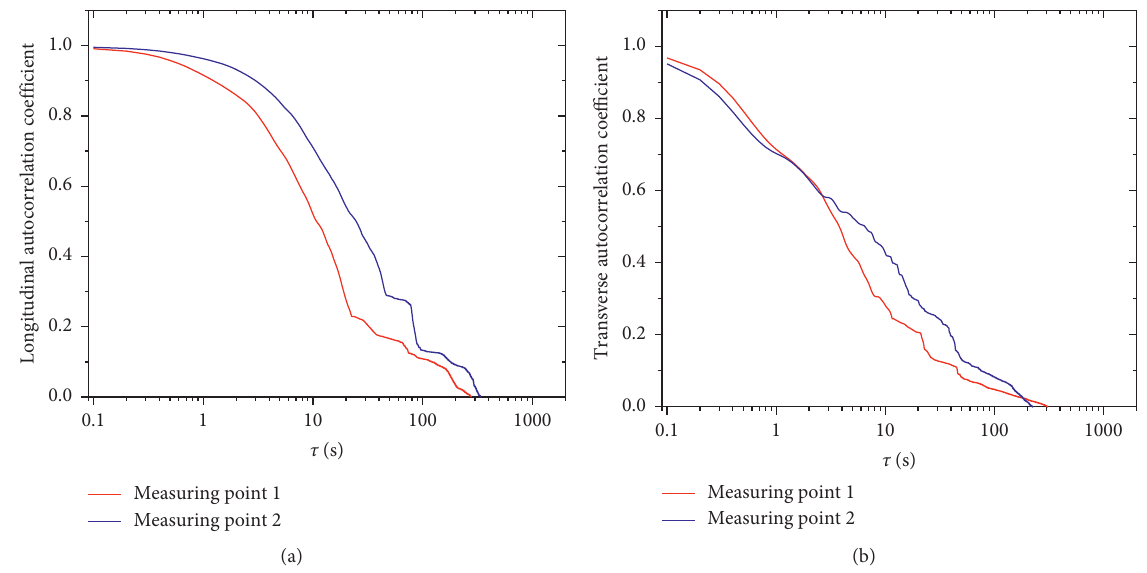
Figure 7: Autocorrelation coefficient varying with time interval. (a) Longitudinal autocorrelation coefficient varying with time interval. (b) Transverse autocorrelation coefficient varying with time